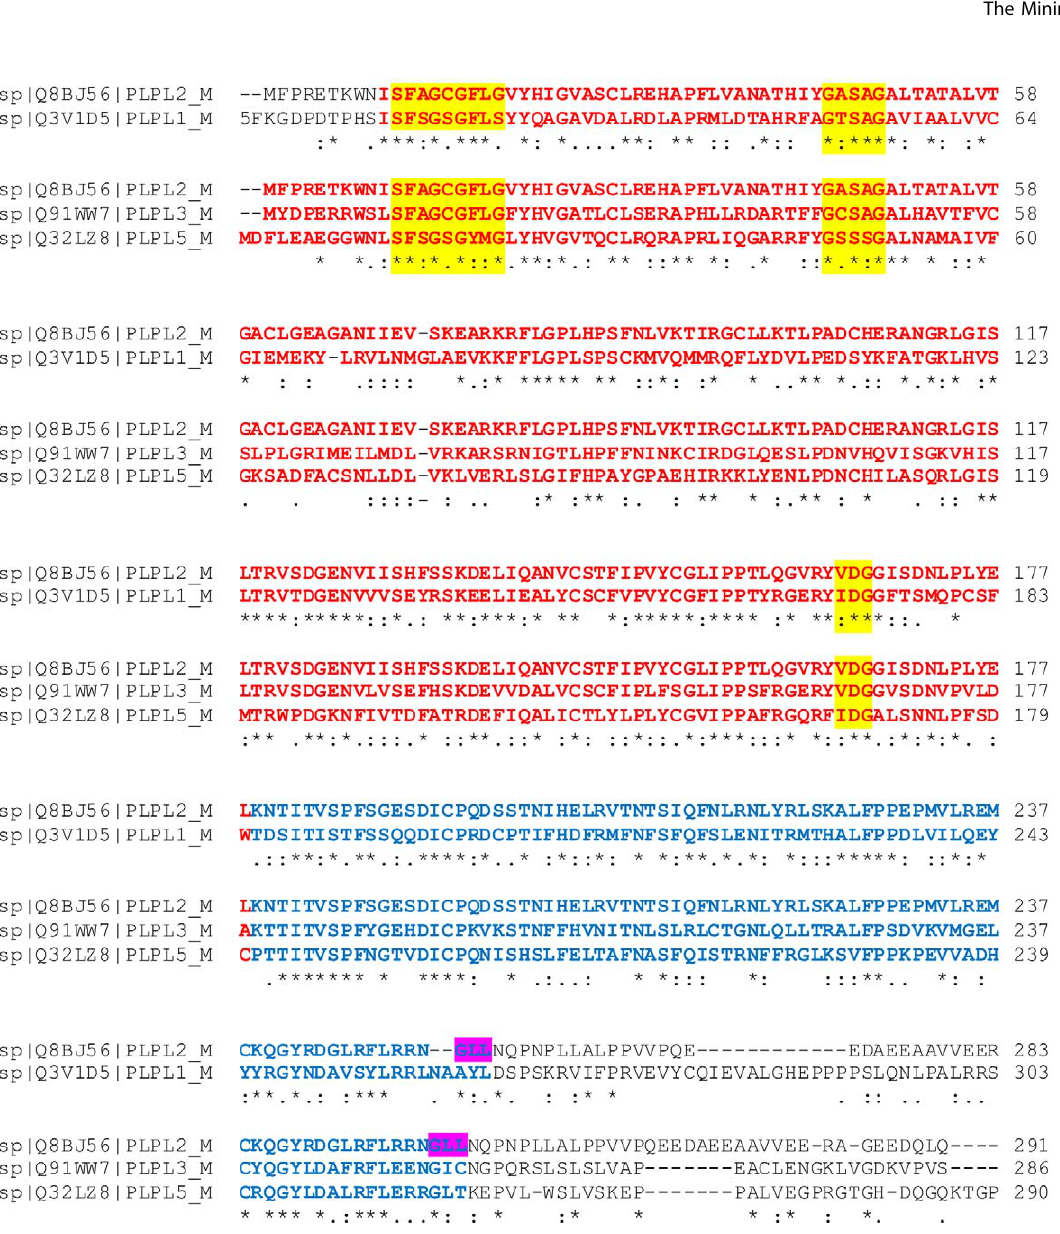
Figure 8. Amino acid sequence alignment of PNPLA family members. The amino acid sequence alignment of mouse PNPLA family members PNPLA1, -2, -3, and -5 shows high sequence conservation at the N-terminal halves of the proteins. Residues at the proposed catalytic sites (oxyanion hole, GXSXG motif, catalytic Asp) are highlighted in yellow. The patatin domain (Ile10-Leu178 for ATGL/PNPLA2) is emphasized in bold red letters. High identity can be also observed in the patatin-related region, up to Leu254 (bold